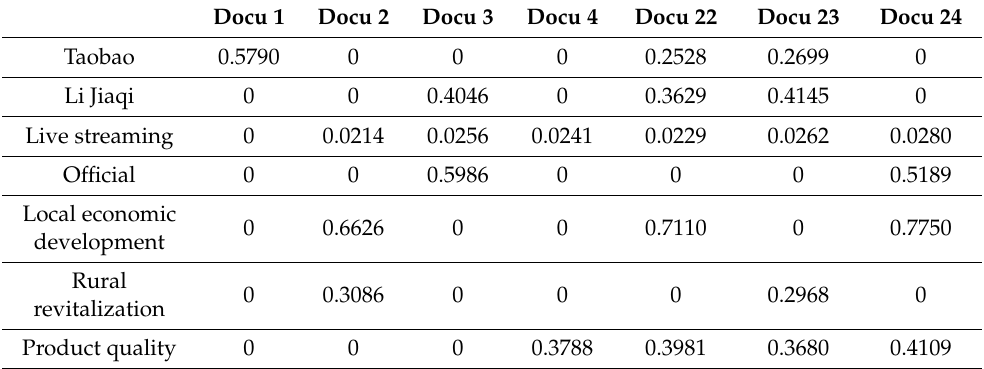
Table 3. “Keyword-document” matrix.